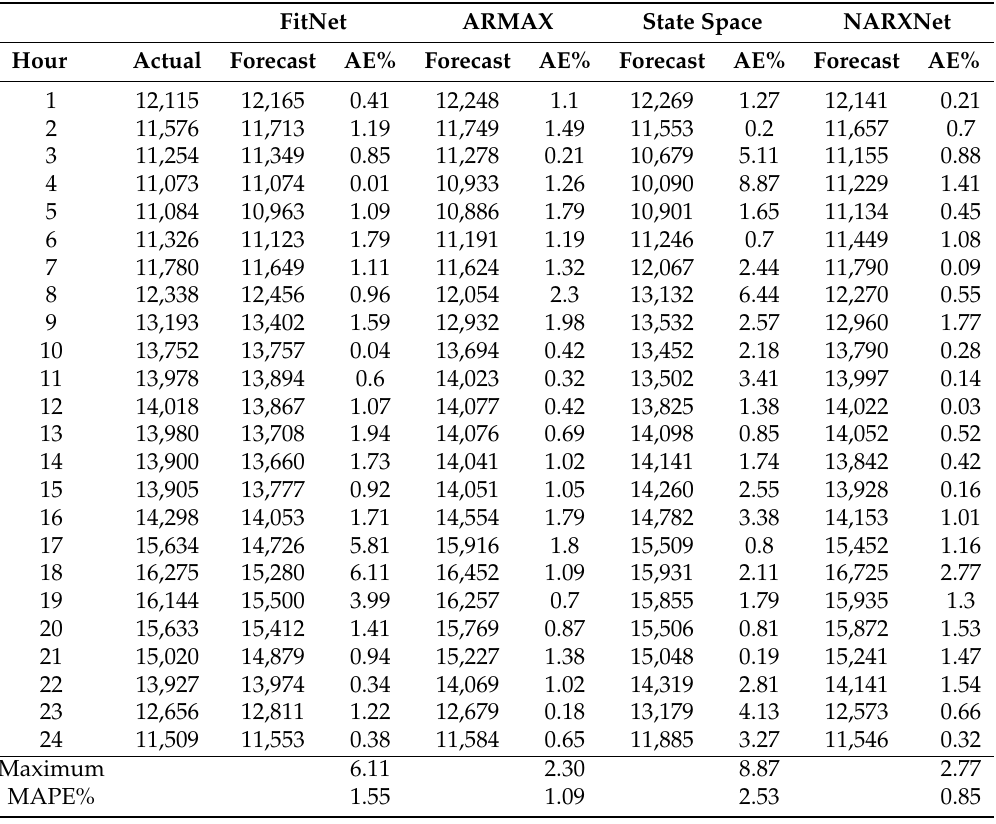
Table 3. Results comparison for FitNet, ARMAX, State Space and NARXNet. FitNet ARMAX State Space NARXNet